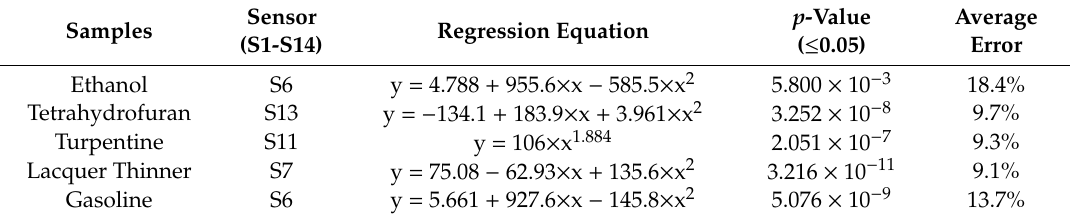
Table 4. Univariate regression analysis.